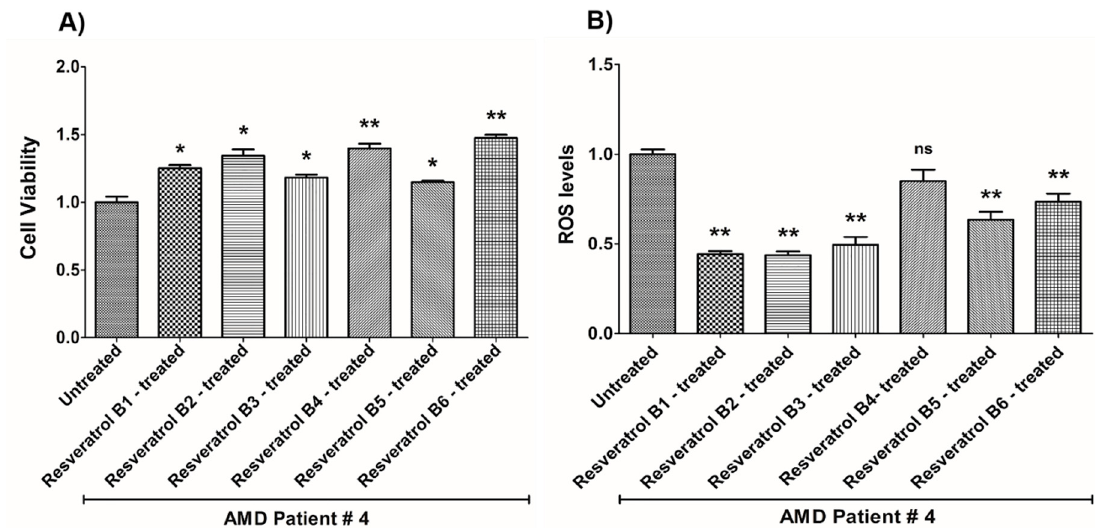
Figure 5. E ff ects of resveratrol formulations on cell viability ( A ) and ROS levels ( B ) in AMD patient #4.